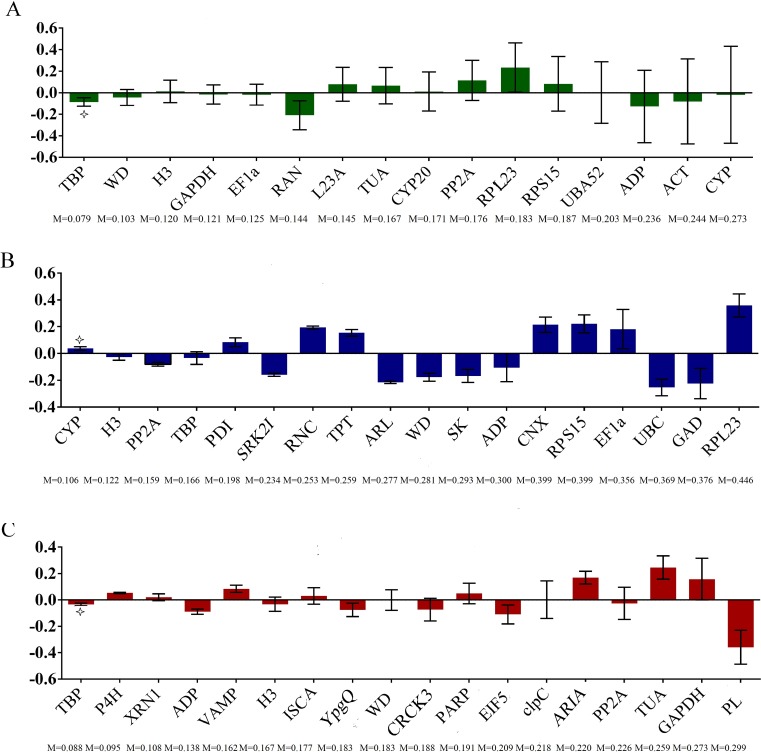
Expression stability of the candidate RGs analyzed by NormFinder.The samples were divided into two subgroups according to the method of leaf and fruit set. The histogram displays the intergroup variation. The error bars represent the intragroup variation. M represents the stability value. Asterisks indicate the best genes. NormFinder analysis of candidate RGs screened from the RNA-Seq and the traditional RGs in both bottle gourd leaves and fruits (A), from the RNA-Seq in bottle gourd leaves (B), and in bottle gourd fruits (C).